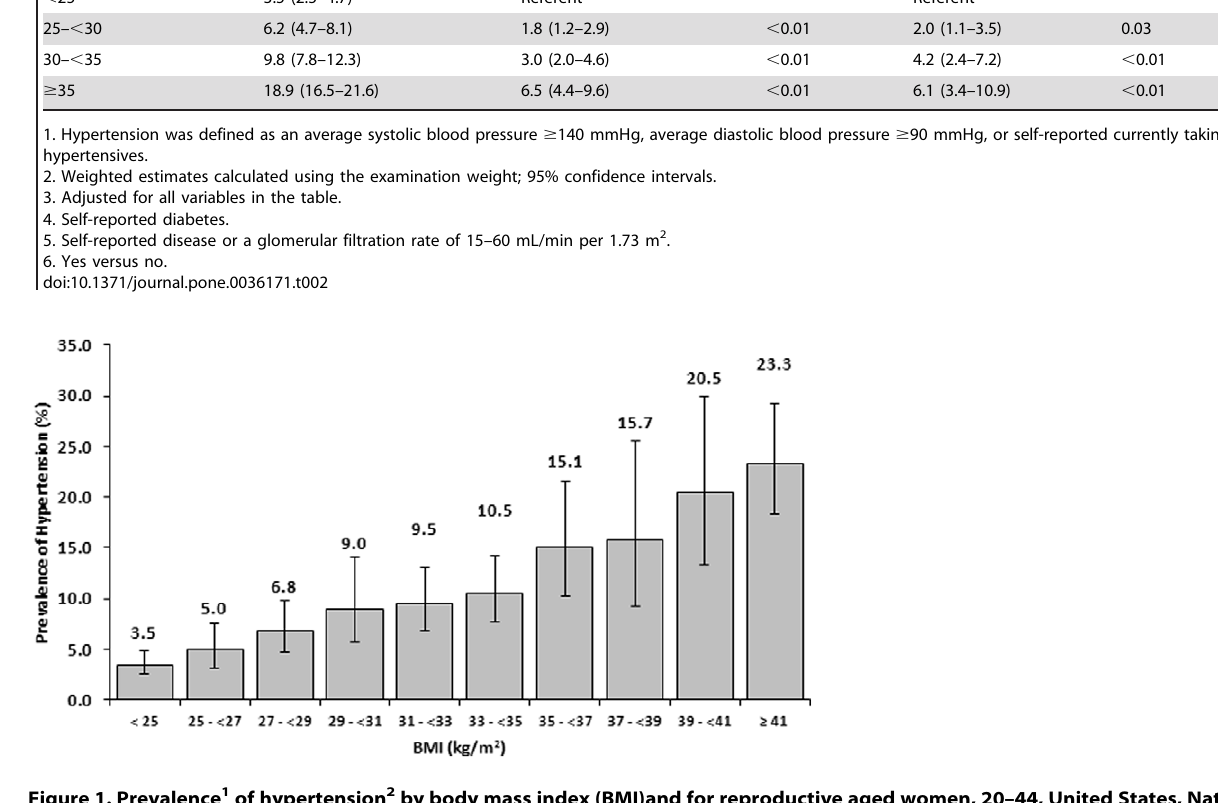
Figure 1. Prevalence 1 of hypertension 2 by body mass index (BMI)and for reproductive aged women, 20–44, United States, National Health and Nutrition Examination Survey, 1999–2008 . 1. Weighted estimates calculated using the examination weight and 95% confidence intervals. 2. Hypertension was defined as an average systolic blood pressure $ 140 mmHg, average diastolic blood pressure $ 90 mmHg, or self- reported currently taking